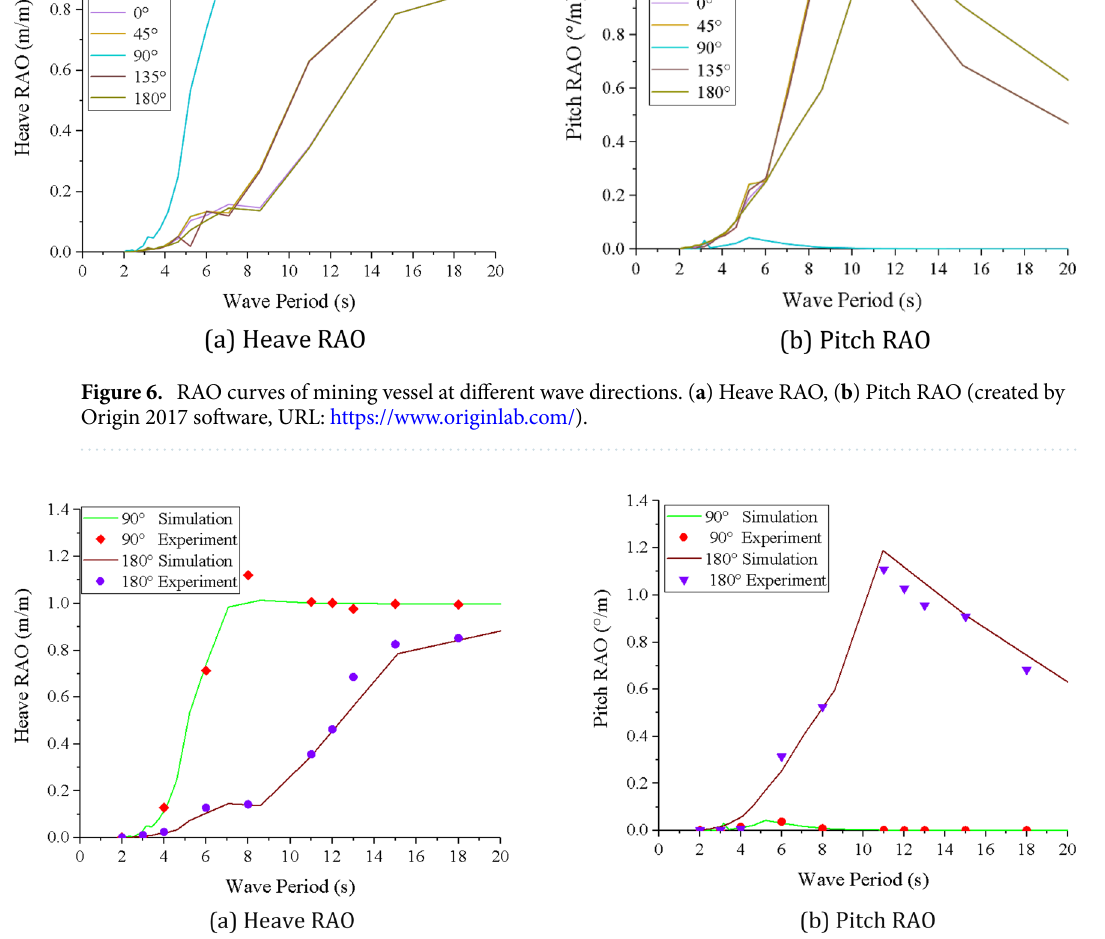
Figure 7. Simulation and experimental results of RAO. ( a ) Heave RAO, ( b ) Pitch RAO (created by Origin 2017 software, URL: https:// www. origi nlab.